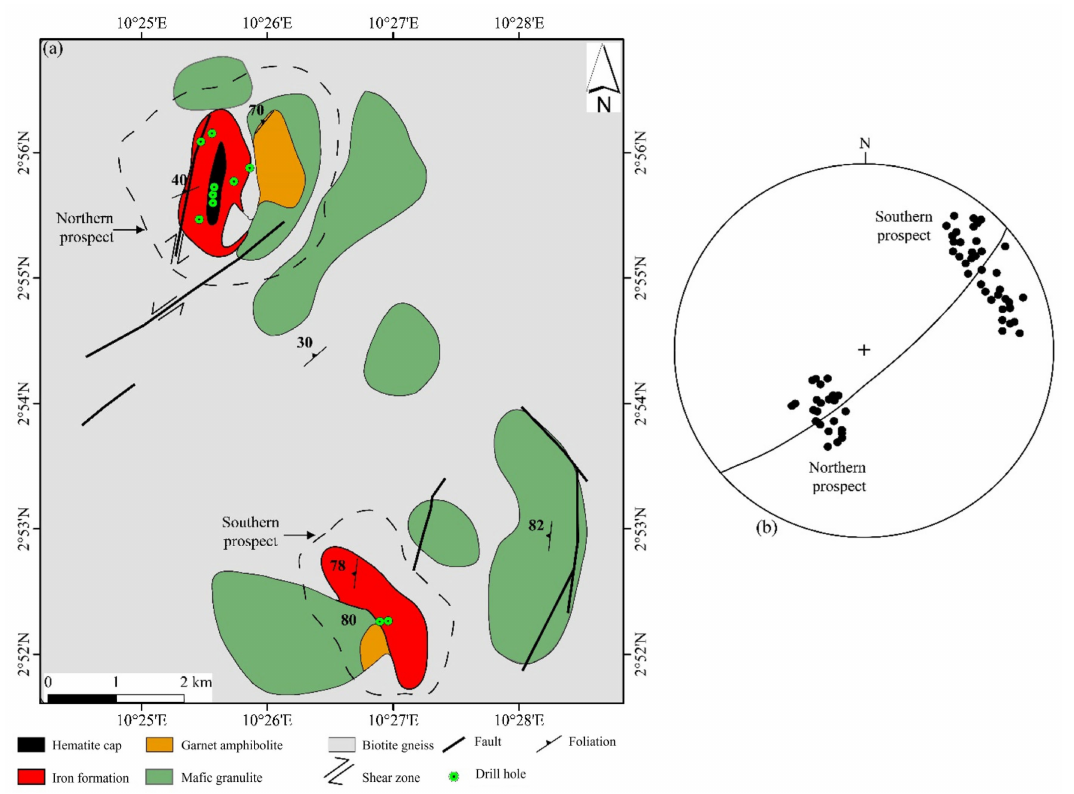
Figure 2. ( a ) Geological map of the Anyouzok iron deposit with drillholes and prospects (northern and southern) locations; ( b ) orientation diagram presenting the S 1 /S 2 foliations of the Anyouzok northern and southern